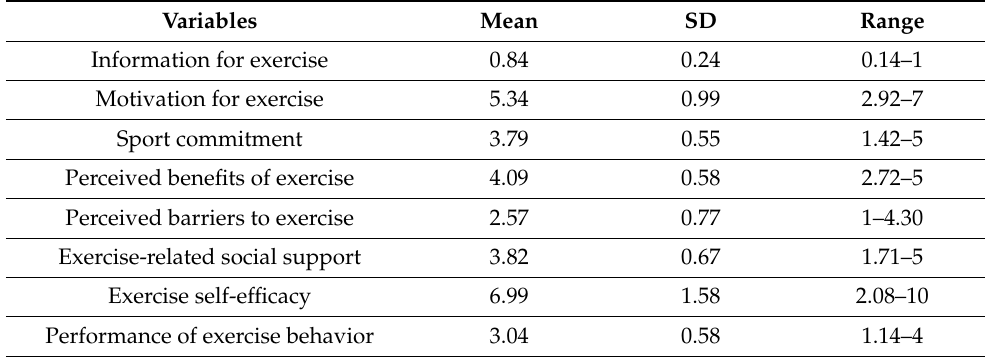
Table 2. Degree of research variables ( N =